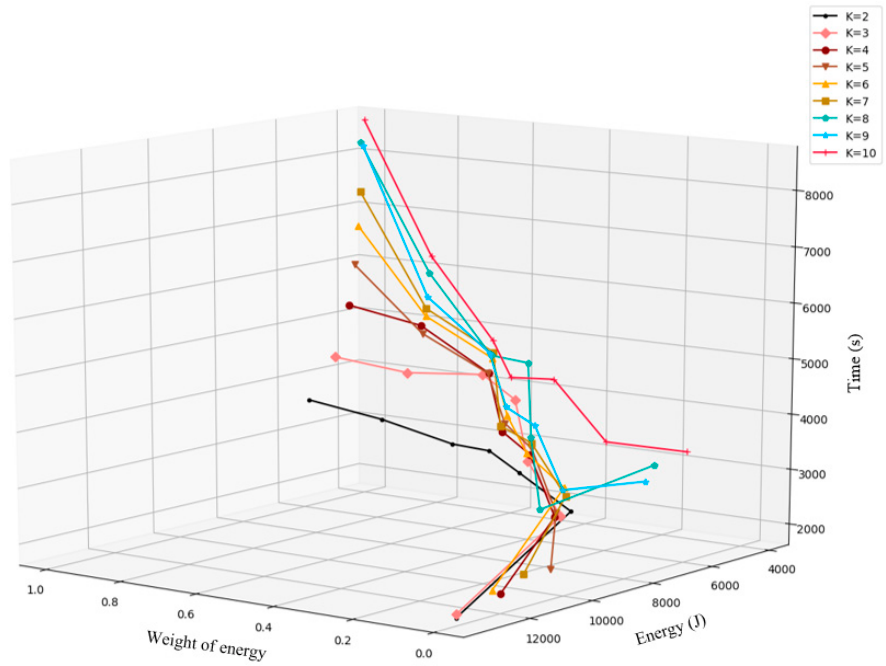
Figure 7. Three-dimensional graph of energy and time variation with different weights.